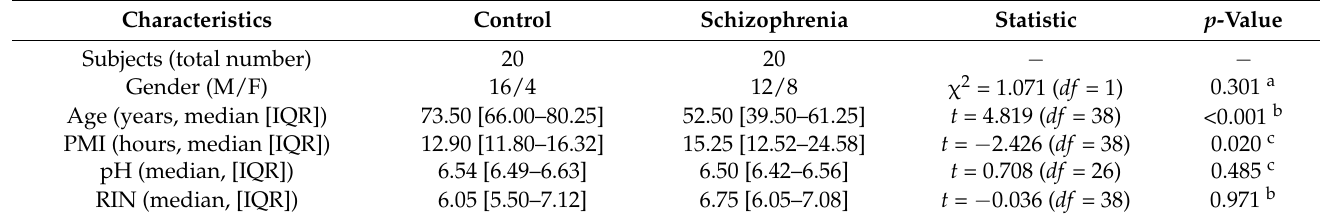
Table 1. Demographic and clinical characteristics of control subjects and schizophrenia